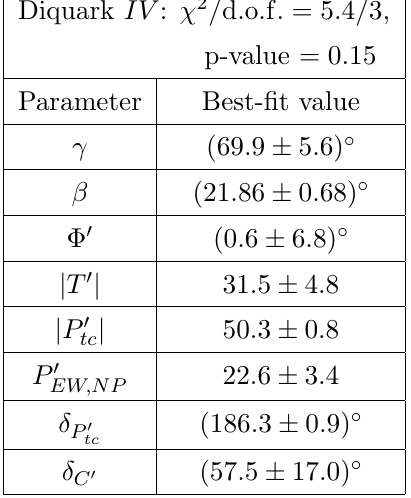
Table 12 . (cid:31) 2 = d : o : f : and best-(cid:12)t values of unknown parameters for the model of diquark IV . min Constraints: B ! (cid:25)K data, measurements of (cid:12) and (cid:13) , j C 0 =T 0 j = 0 : 2.